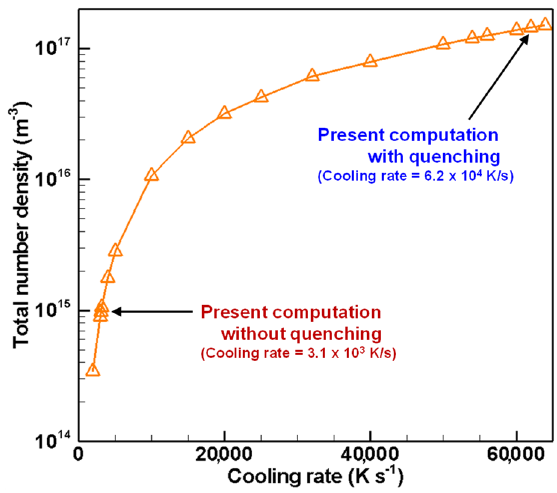
Figure 17. Cooling rate dependence on total number density of silicon nanoparticles.